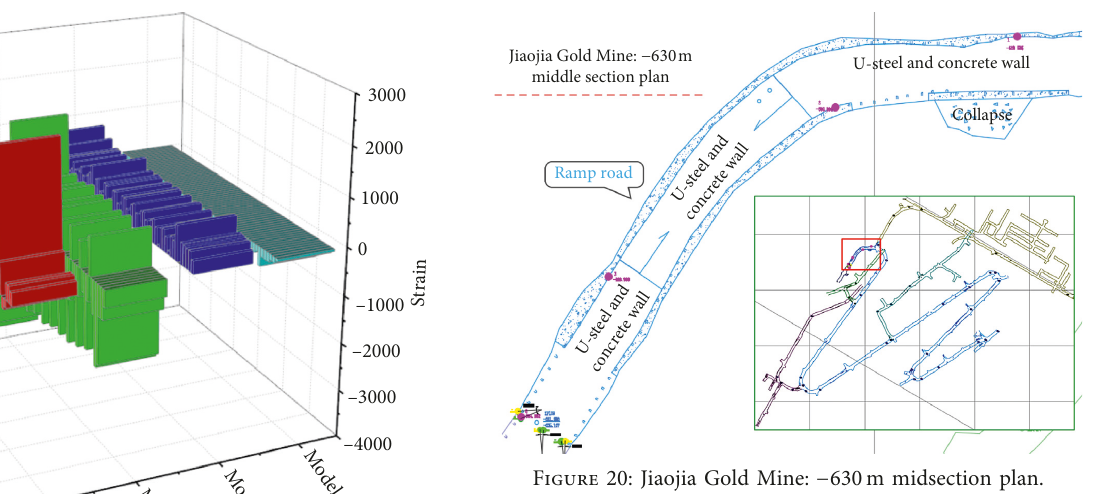
Jiaojia Gold Mine: −630m middle section plan